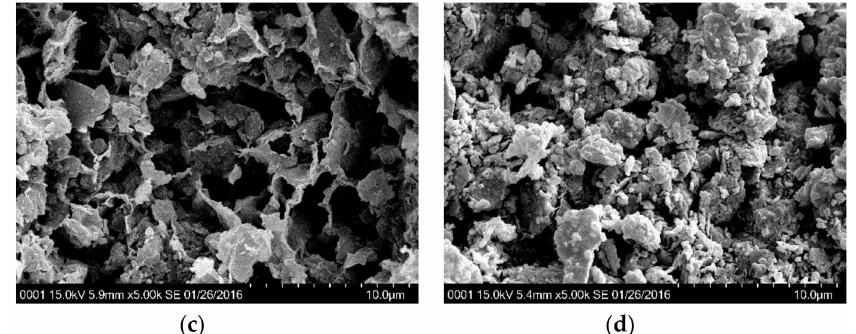
Figure 9. The SEM images of samples magnified 5000 times. ( a ) KMicro + 0%; ( b ) KMicro + 5%; ( c ) B20%K80%Micro + 0%; ( d ) B20%K80%Micro + 5%.